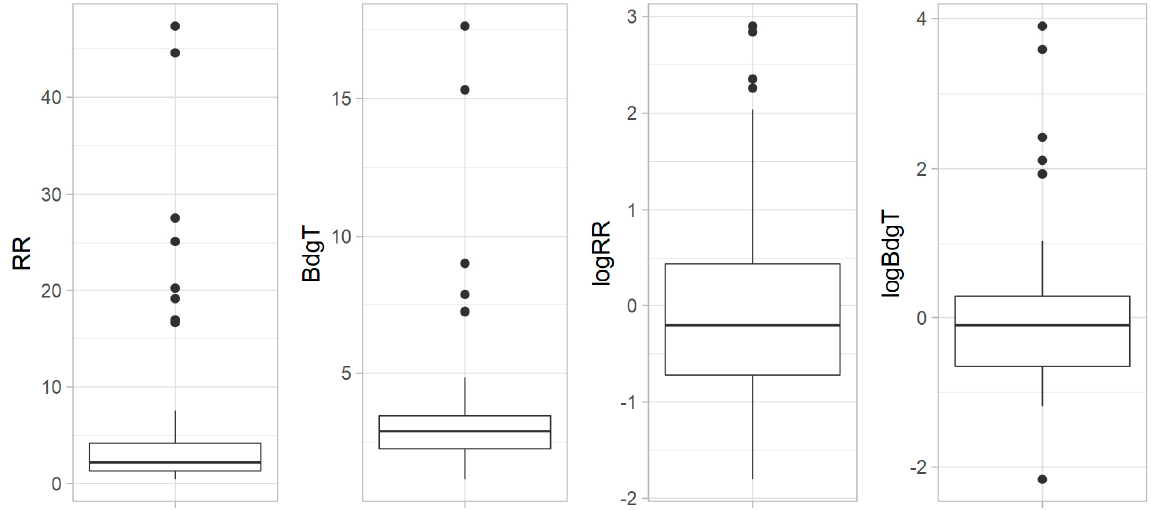
Figure 4. Boxplots of respiration rate (RR) and biodegradability period (BdgT) and their log transformed data, showing the distribution of these parameters in the 73 sampled lakes. The line inside the box represents the median value, and the upper and lower sections of the box show the upper and lower quartiles. The whiskers represent 1.5 times the interquartile range. Outliers are marked as points outside the whiskers. Table 1. Parameters describing the biodegradability of DNOM.